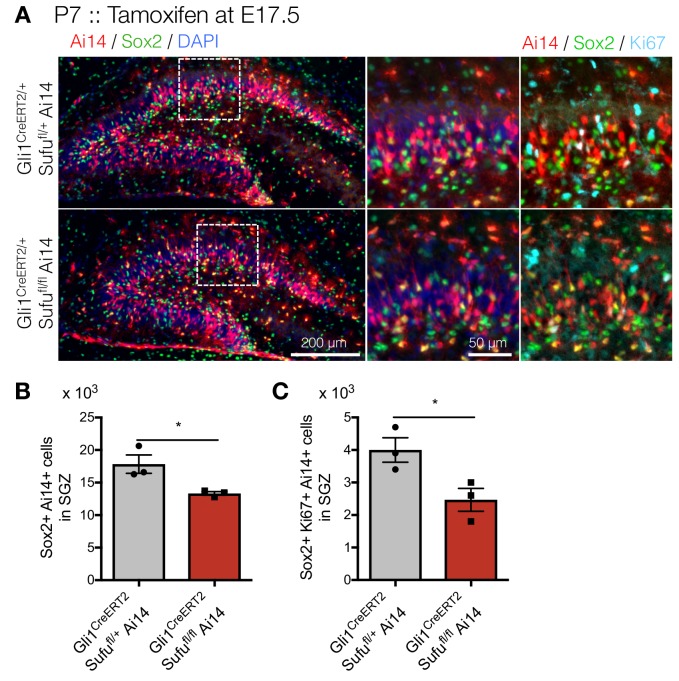
Prenatal deletion of Sufu in NSCs of ventral hippocampus leads to reduction of NSCs in the postnatal DGs.(A) Representative immunofluorescence images for Ai14 (red), Sox2 (green) and DAPI (blue) in the DGs of Gli1CreERT2/+;Sufufl/+;Ai14 and Gli1CreERT2/+;Sufufl/fl;Ai14 mice. (B,C) Quantification of Ai14+/Sox2 +cells (B) and Ai14+/Sox2+/Ki67 +cells (C) in DGs [n = 3 biological replicates per group]. Values represent mean ±SEM; *p<0.05. Student’s t-test.10.7554/eLife.42918.021Figure 5—figure supplement 1—source data 1.Extended numerical data and statistical analysis for Figure 5—figure supplement 1.